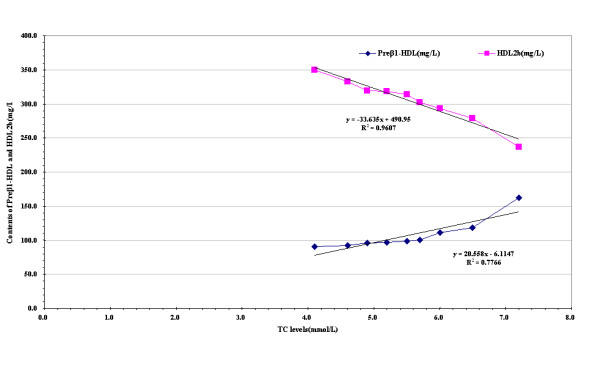
Relations of the preβ1-HDL and HDL2b contents to the levels of TC.